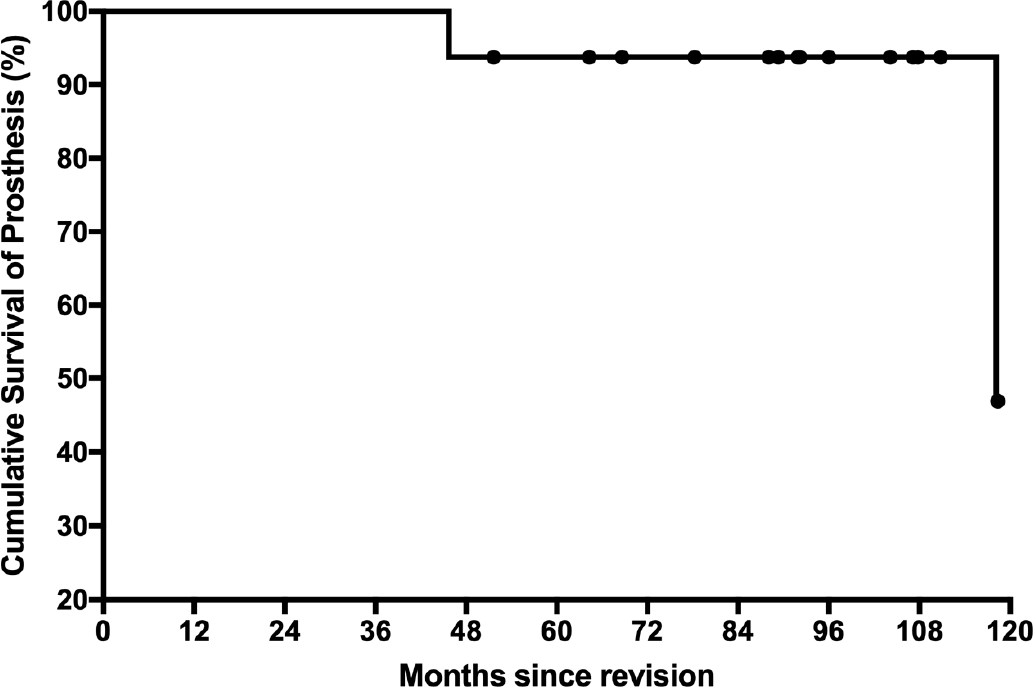
Figure 3. The cumulative survival of revision prosthesis is shown. Patients were censored at last